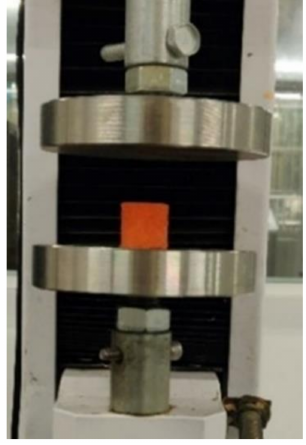
Figure 3. Compression